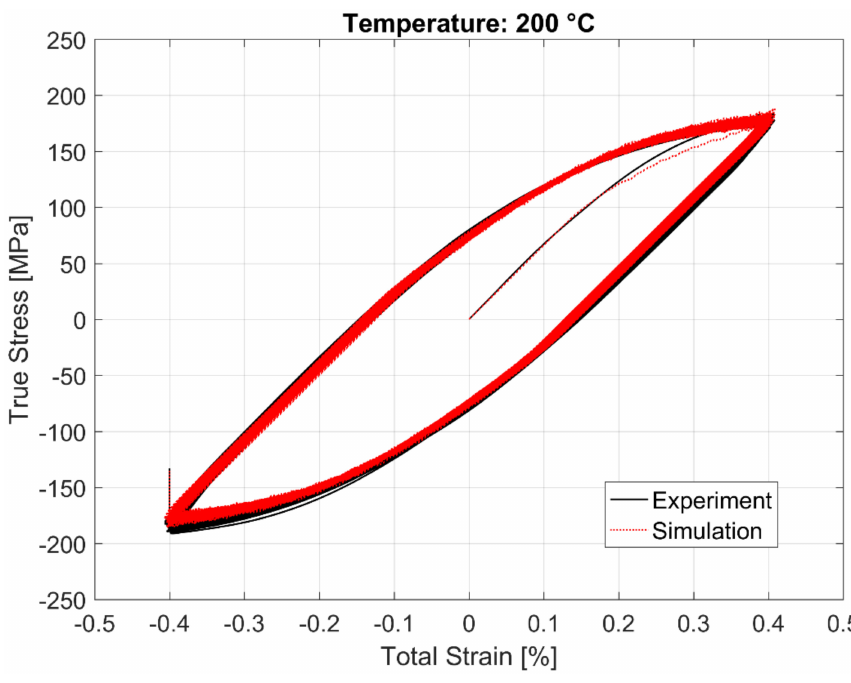
Figure 22. Experimental vs. visco-plastic model prediction at 200 ◦ C.